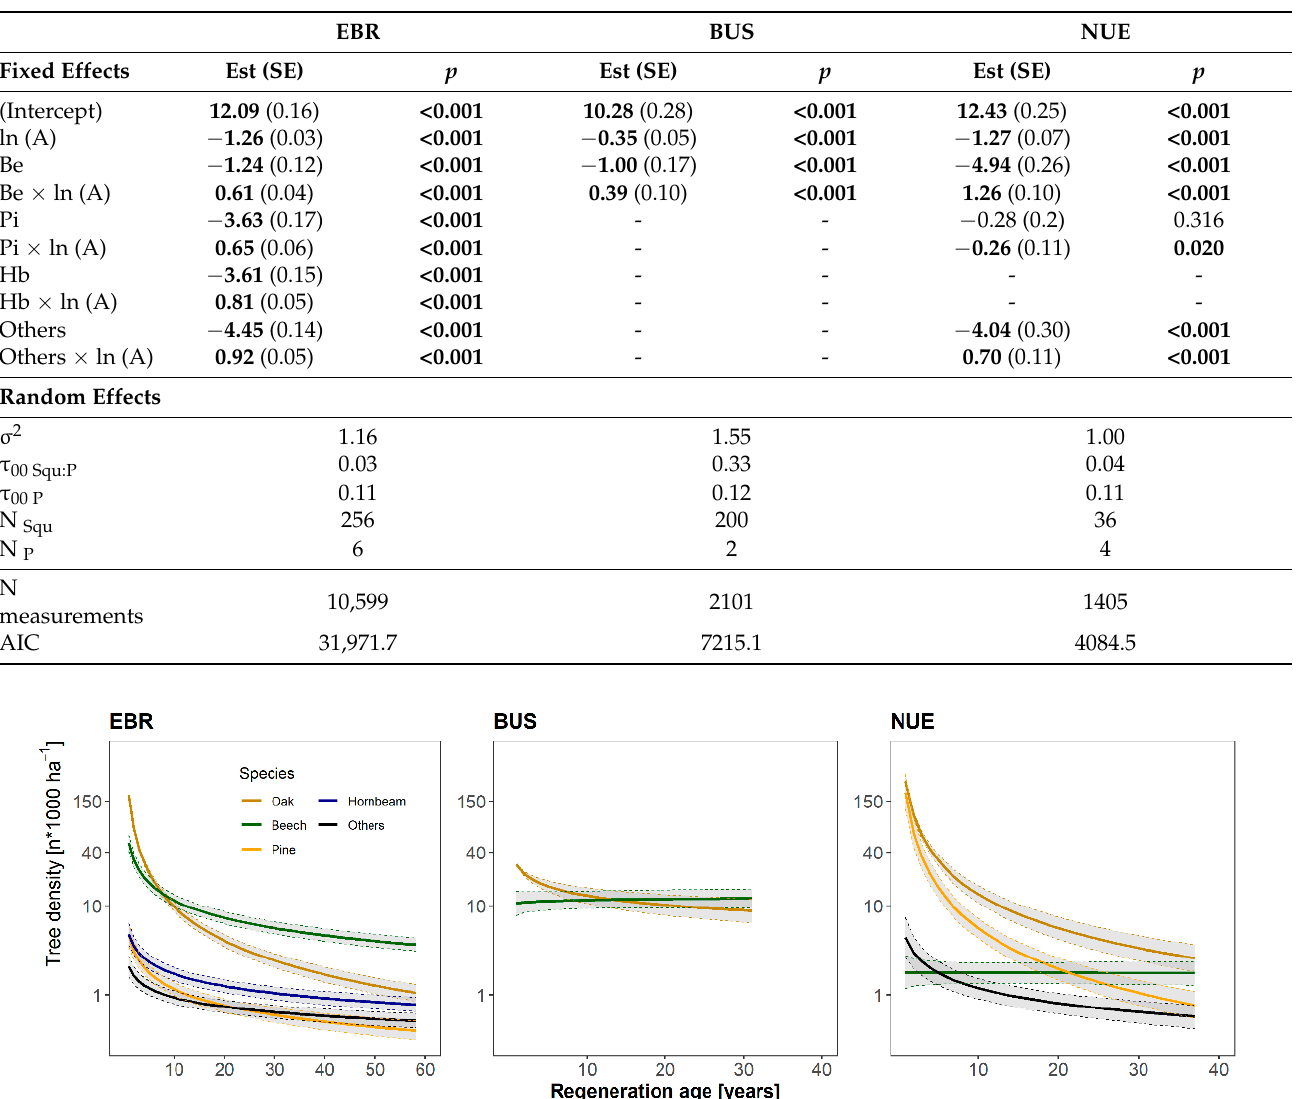
Figure 3. Estimated tree densities of the regenerated tree species (Equation (3)); note the logarithmic scaling of the y- axis and the different scaling of the x- axes.